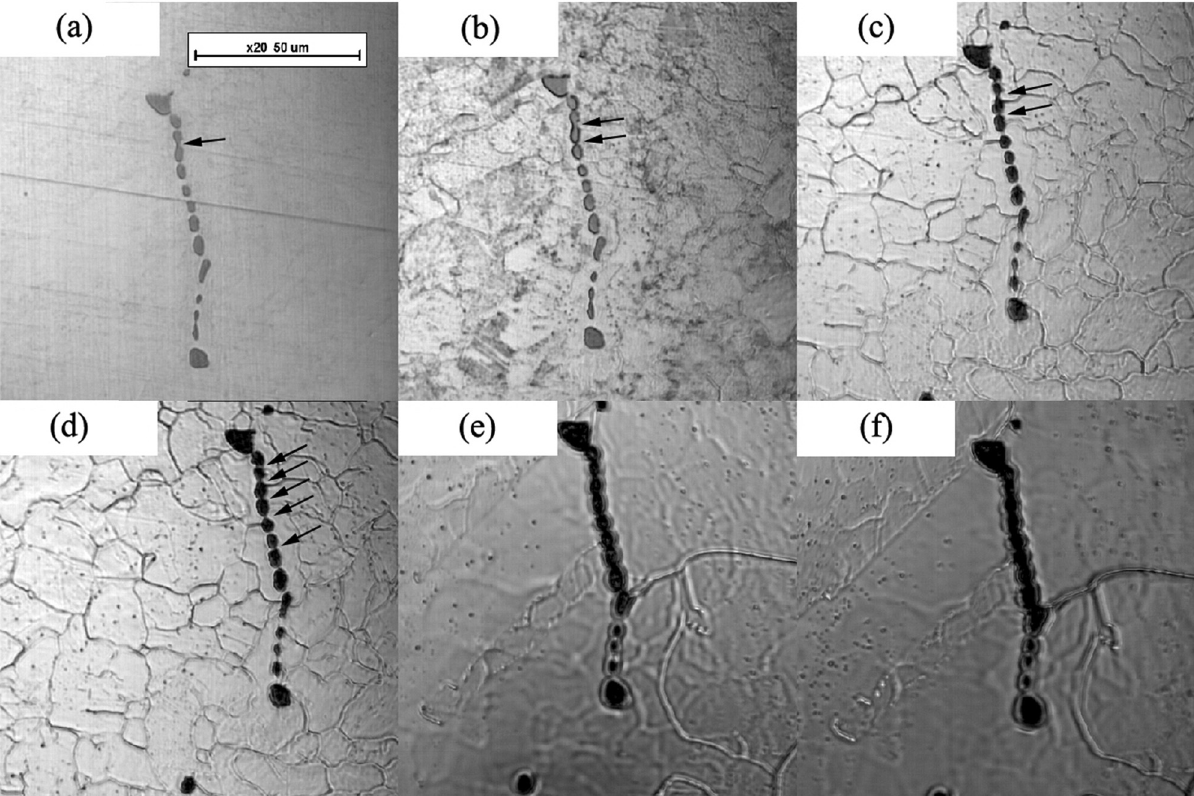
Figure 8: The morphology variation of MnS during heating and holding process ( a – c ) heating process, ( d – f ) sample holded at 1,250°C for 0, 120, and 390 s, respectively. ( a ) 700°C, ( b ) 900°C, ( c ) 1,100°C, ( d ) 1,250°C, ( e ) 1,250°C, ( f )